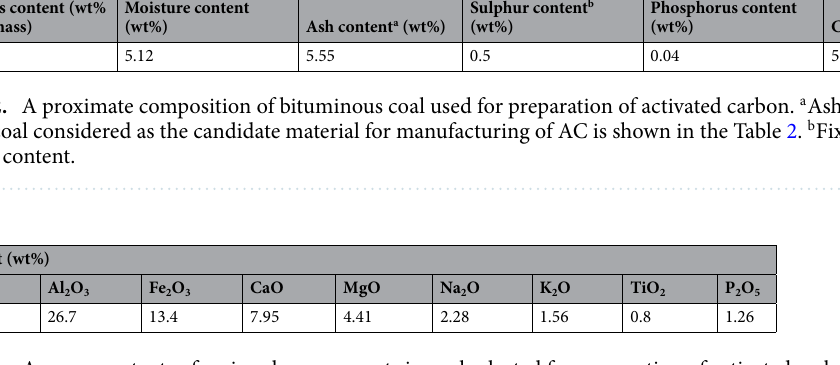
Table 3. Average contents of main ash components in coal selected for preparation of activated